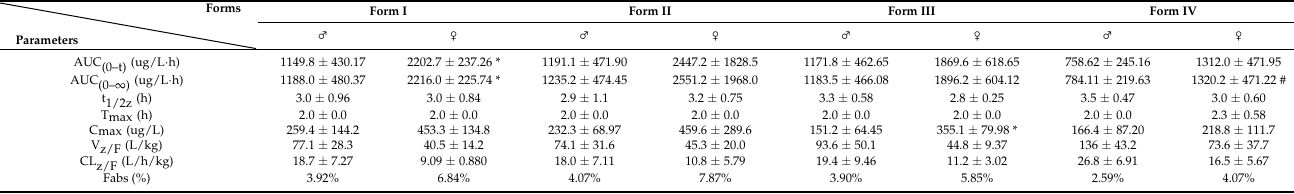
Table 2. Summary of pharmacokinetic parameters after oral administration of CK polymorphs in rats (20 mg/kg) (non- compartment